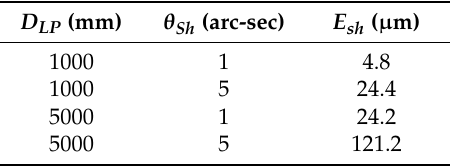
Table 1. Error analysis of laser-source vibration